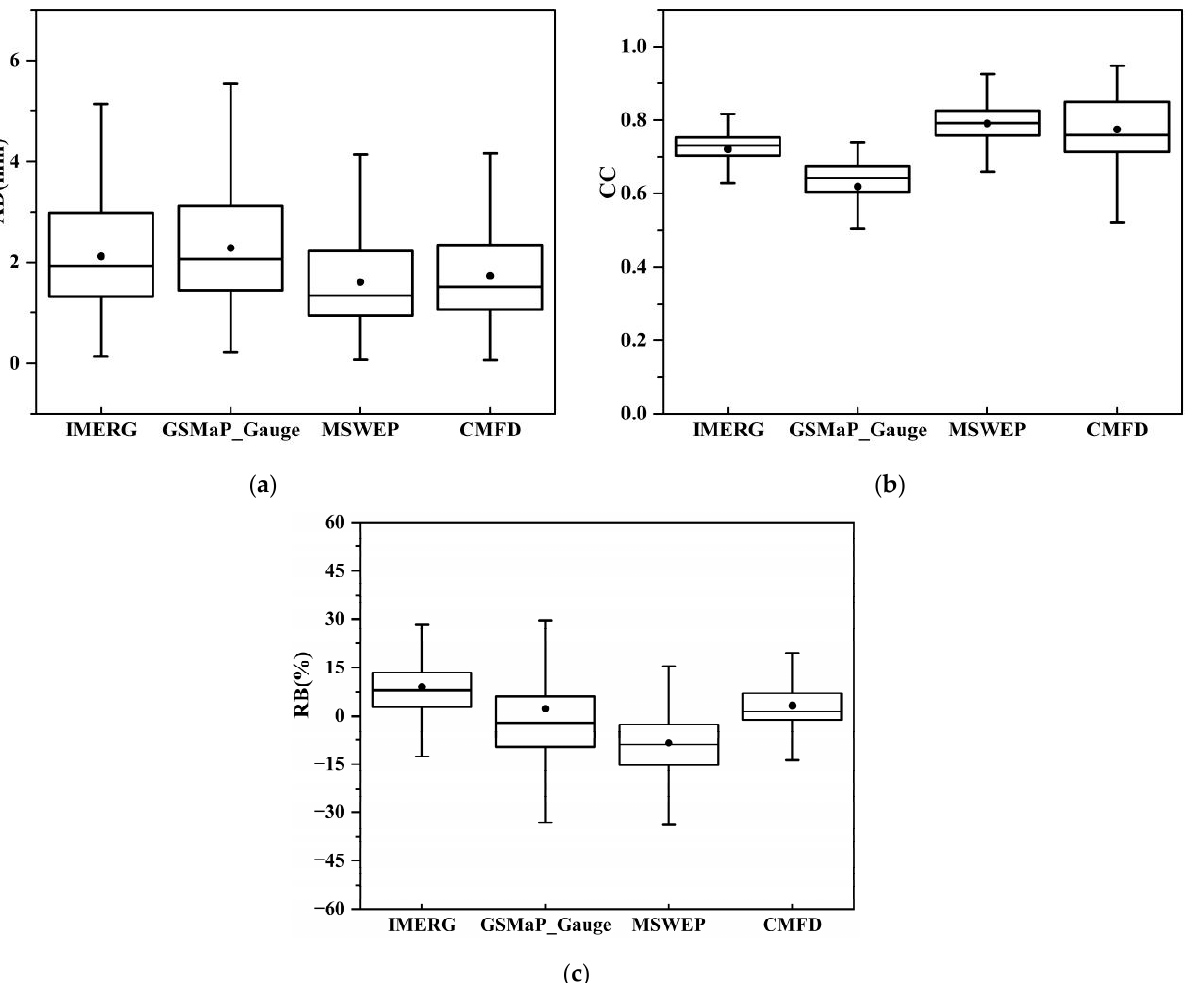
Figure 3. Boxplots for the conventional indices: ( a ) AD ( b ) CC ( c ) RB between the rain gauge data and the four SPPs at 821 urban gauges.